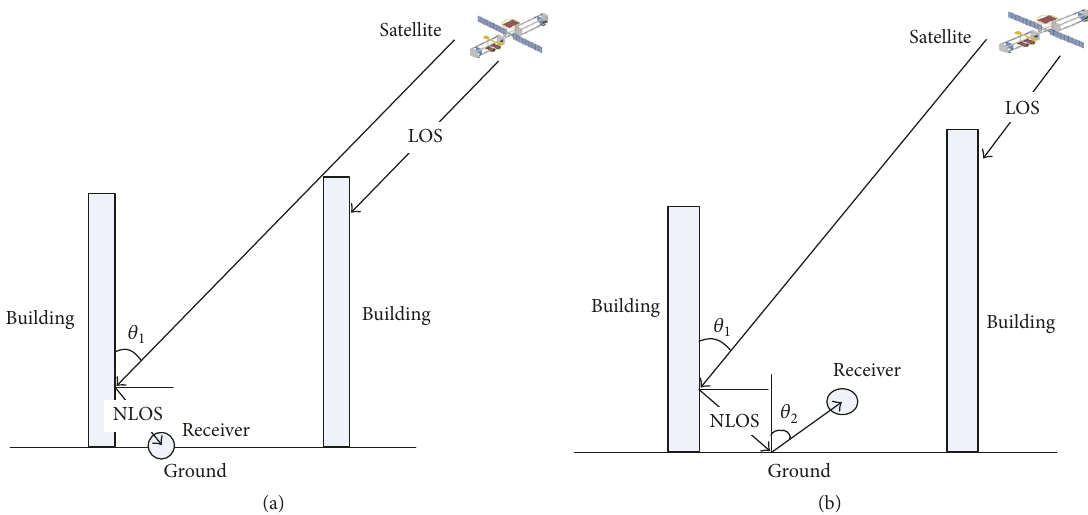
Figure 1: The basic geometry of LOS signal and NLOS signal: single reflection (a) and double reflection (b).